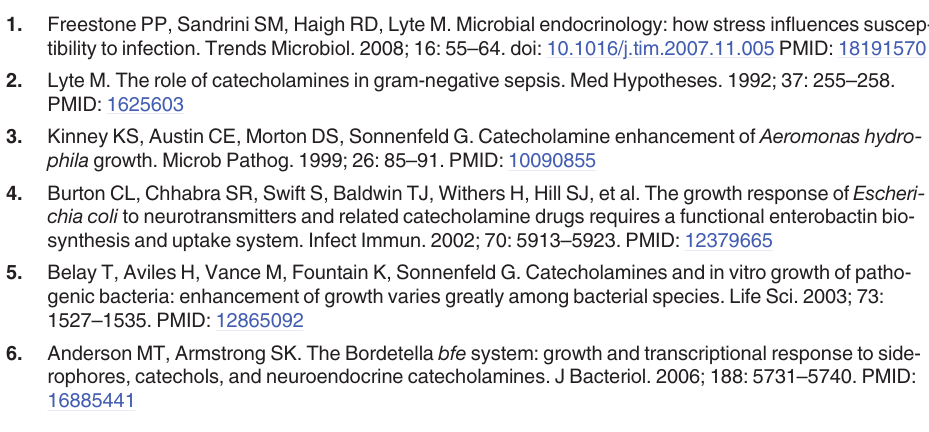
S5 Fig. Function classification of differentially expressed genes. Up or down means up or down-regulated by serum/Epi/NE/DA. Gene functions were sorted according to COG catego- ries: C: Energy production and conversion; D: Cell cycle control, cell division, chromosome partitioning; E: Amino acid transport and metabolism; F: Nucleotide transport and metabo- lism; G: Carbohydrate transport and metabolism; H: Coenzyme transport and metabolism; I: Lipid transport and metabolism; J: Translation, ribosomal structure and biogenesis; K: Tran- scription; A, RNA processing and modification; L: Replication, recombination and repair; M: Cell wall/membrane/envelope biogenesis; O: Posttranslational modification, protein turnover, chaperones; P: Inorganic ion transport and metabolism; Q: Secondary metabolites biosynthe- sis, transport and catabolism; R: General function prediction only; T: Signal transduction mechanisms; U: Intracellular trafficking, secretion, vesicular transport; V: Defense mecha- nisms; S/N: Function unknown in COG. S1 Table. Primers used in this